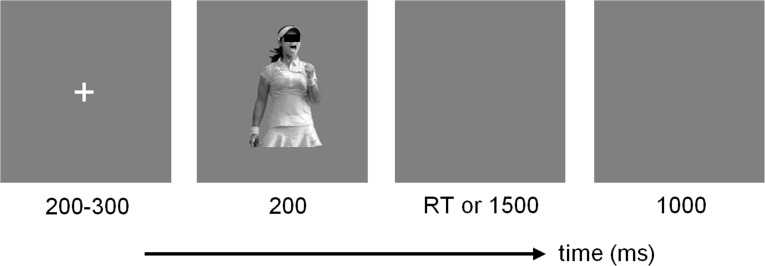
Schematic diagram of one experimental trial.